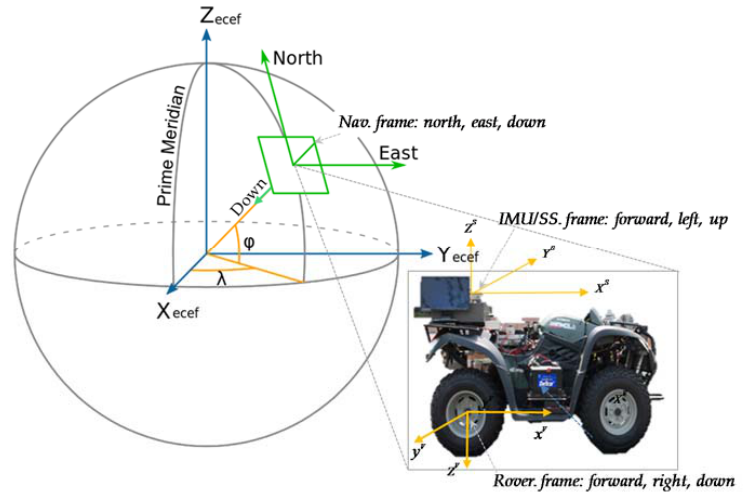
Figure 2. Illustration of the reference frames used for Planetary Rovers .